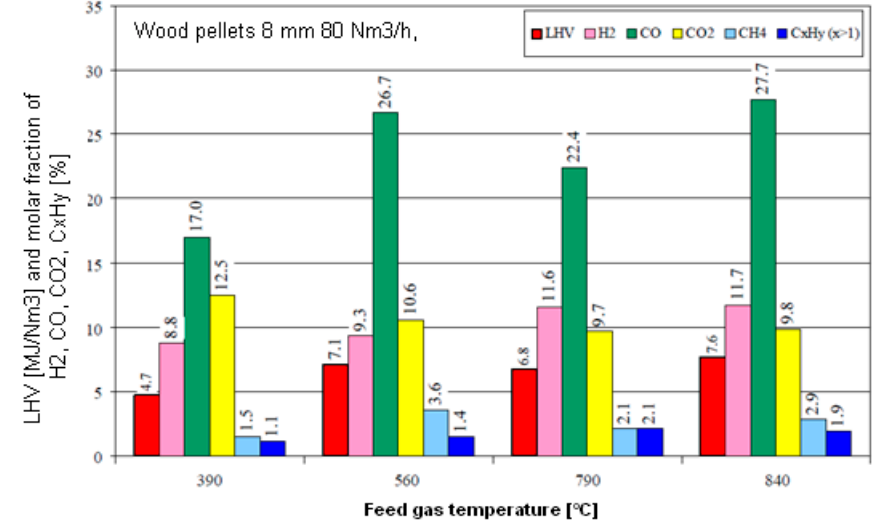
Figure 13. Influence of temperature of the feed gas on the average values of LHV and composition of dry fuel gas. Average values are taken from Phase II for batch type gasification 20 kg of 8 mm wood pellets.